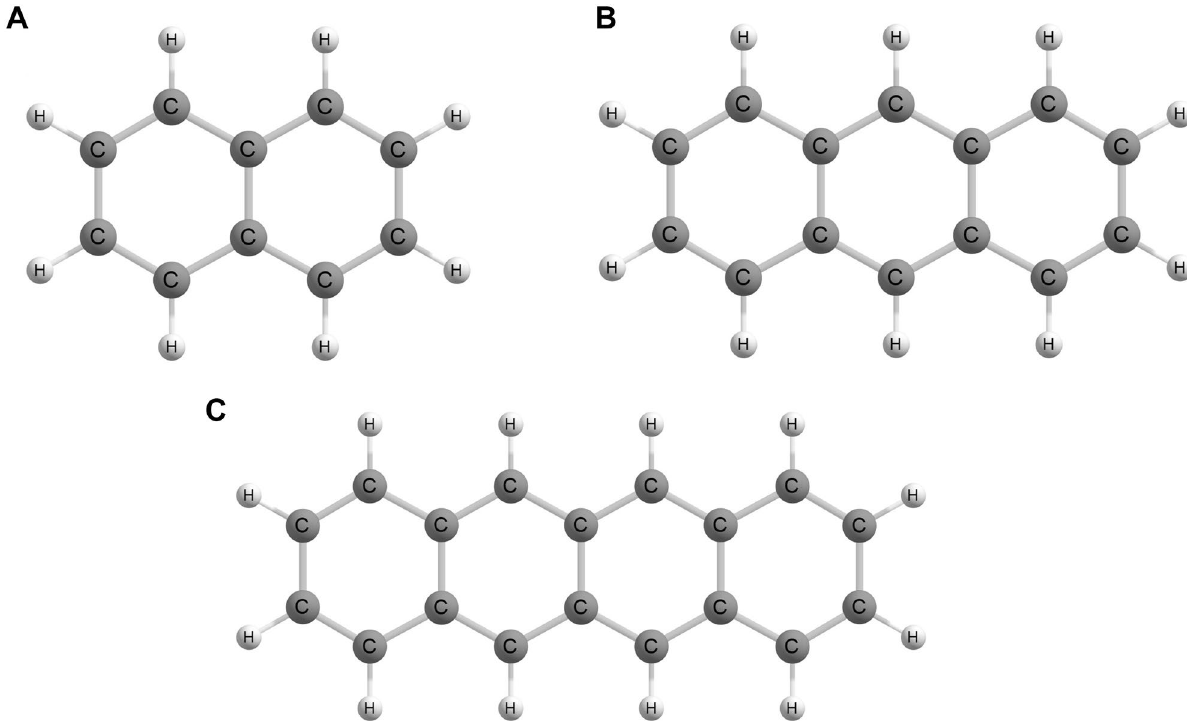
Figure 1. Schematic representation of ( A ) naphthalene, ( B ) anthracene, and ( C )